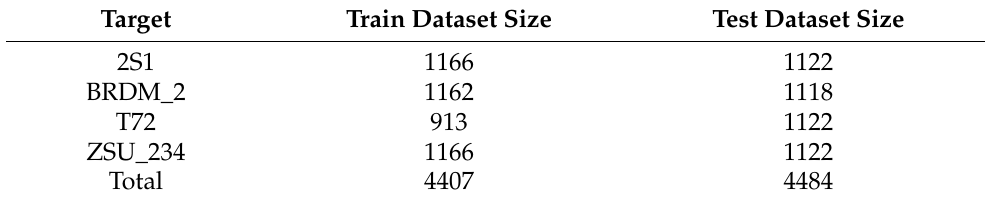
Table 3. The size of EOC1